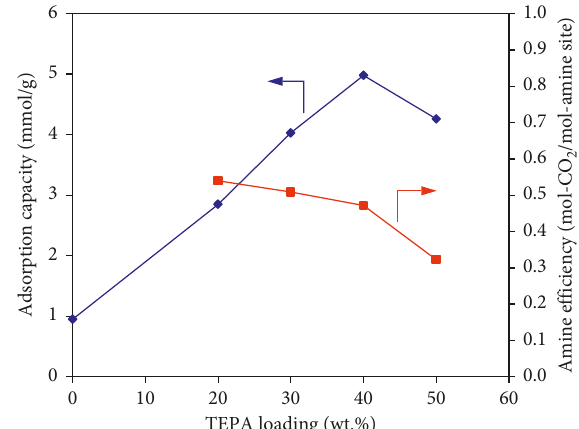
Figure 5: CO 2 adsorption capacity and amine efficiency of MgO with different TEPA